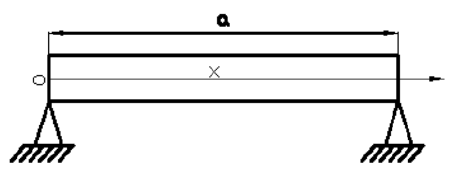
Figure 4. Schematic diagram of the simplified structure of the simply supported beam.